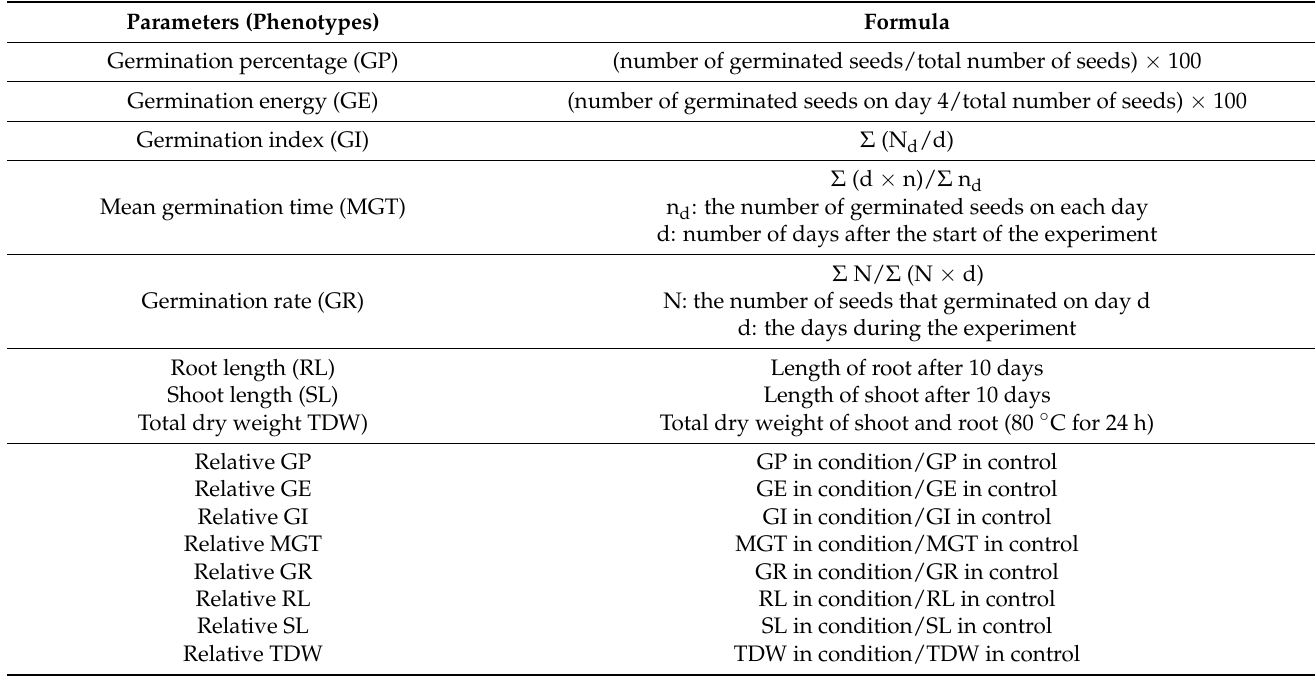
Table 3. Plant parameters (phenotypes) and formulae for their